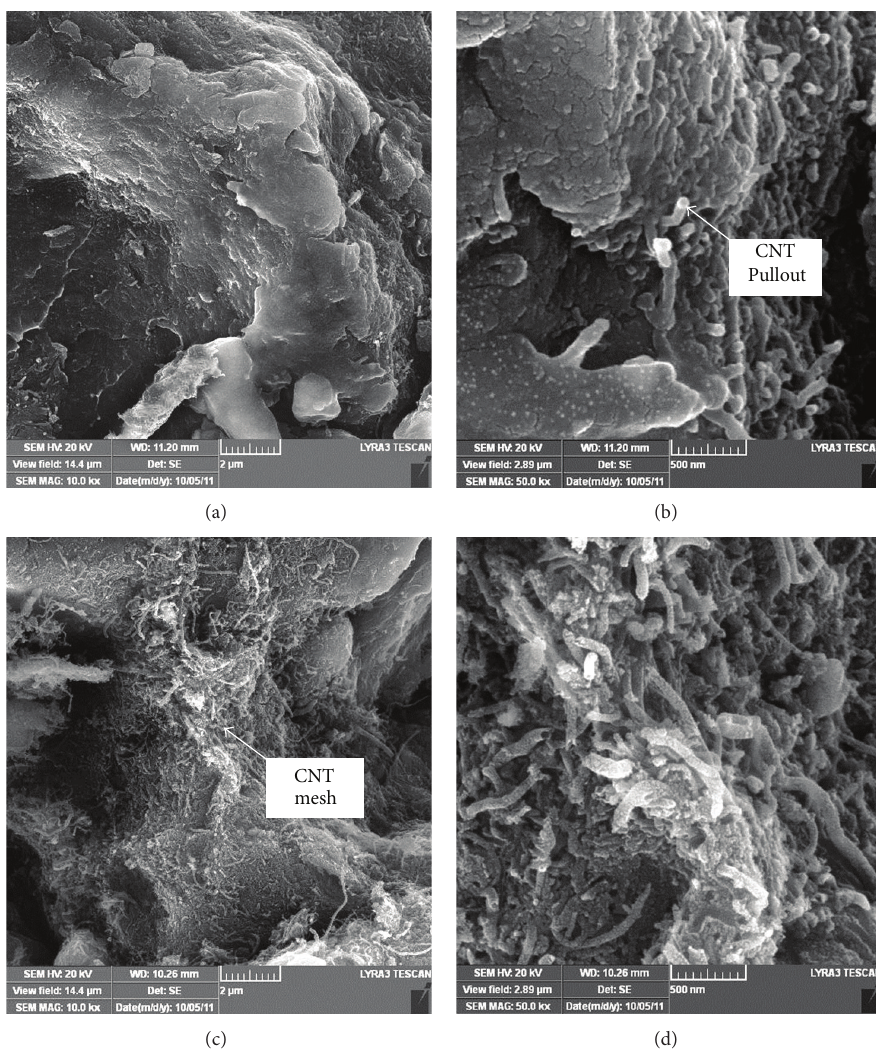
Figure 5: SEM micrographs of fractured surfaces of Al6061 containing (a, b) 1wt.% CNTs and (c, d) 2 wt.%